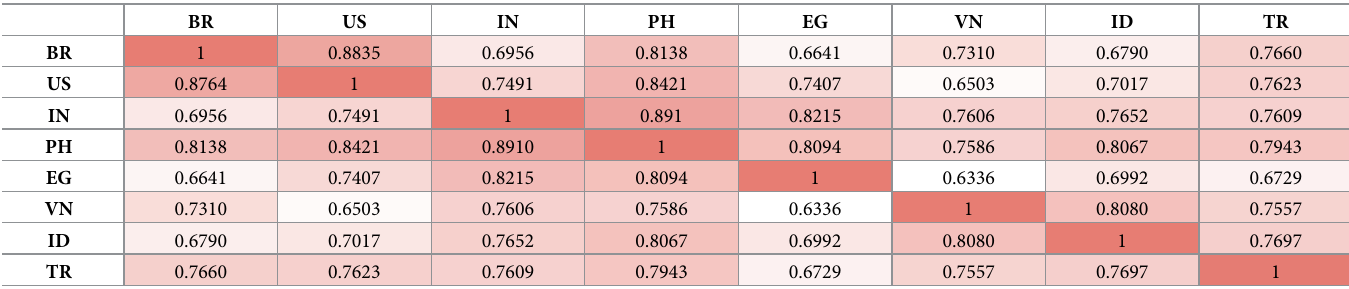
Table 3. Pairwise ranking correlation results for all countries.